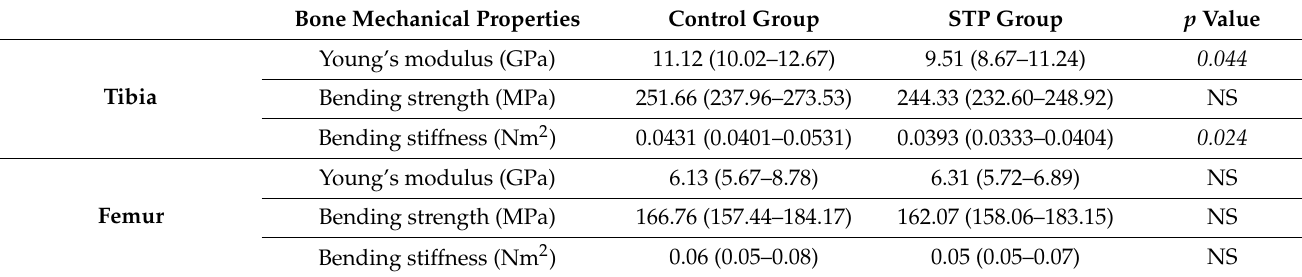
Table 5. The effect of 24 weeks administration of stiripentol on mechanical properties of rat tibia and femur in three-point bending test (STP group—group received stiripentol for 24 weeks). Results presented as: median (lower quartile—upper quartile); NS—not